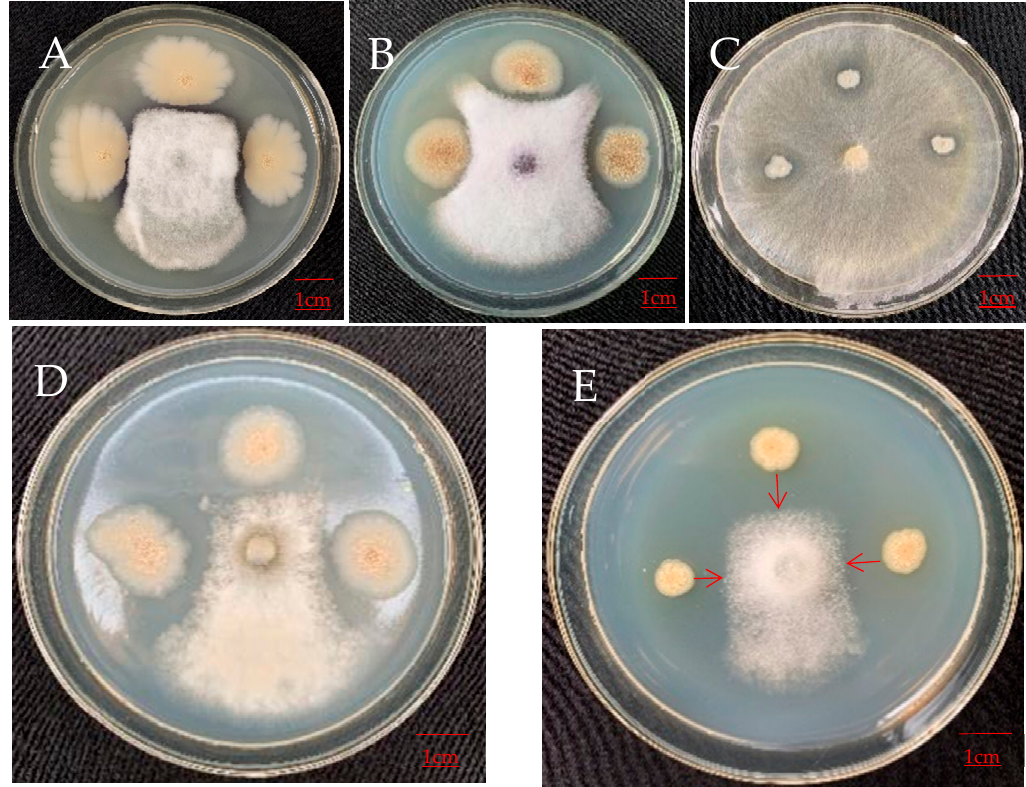
Figure 4. Profile of apple endophytic bacteria against plant fungal pathogens. ( A ): Alternaria alternata